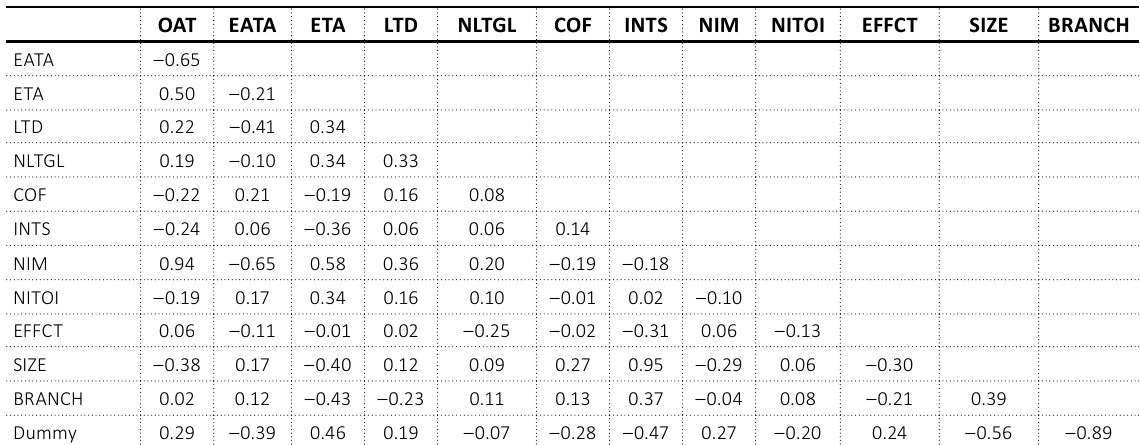
Table 2. Correlation coefficients between independent